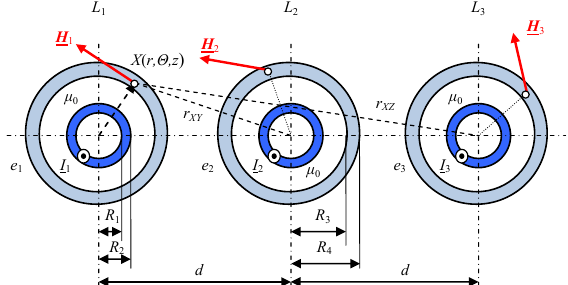
Fig. 2. Three-phase single-pole flat shielded high-current